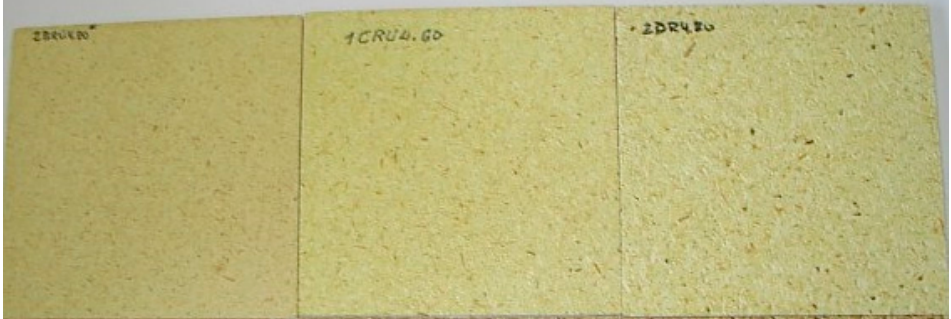
Figure 1. Experimental panel samples for thermal conductivity testing.